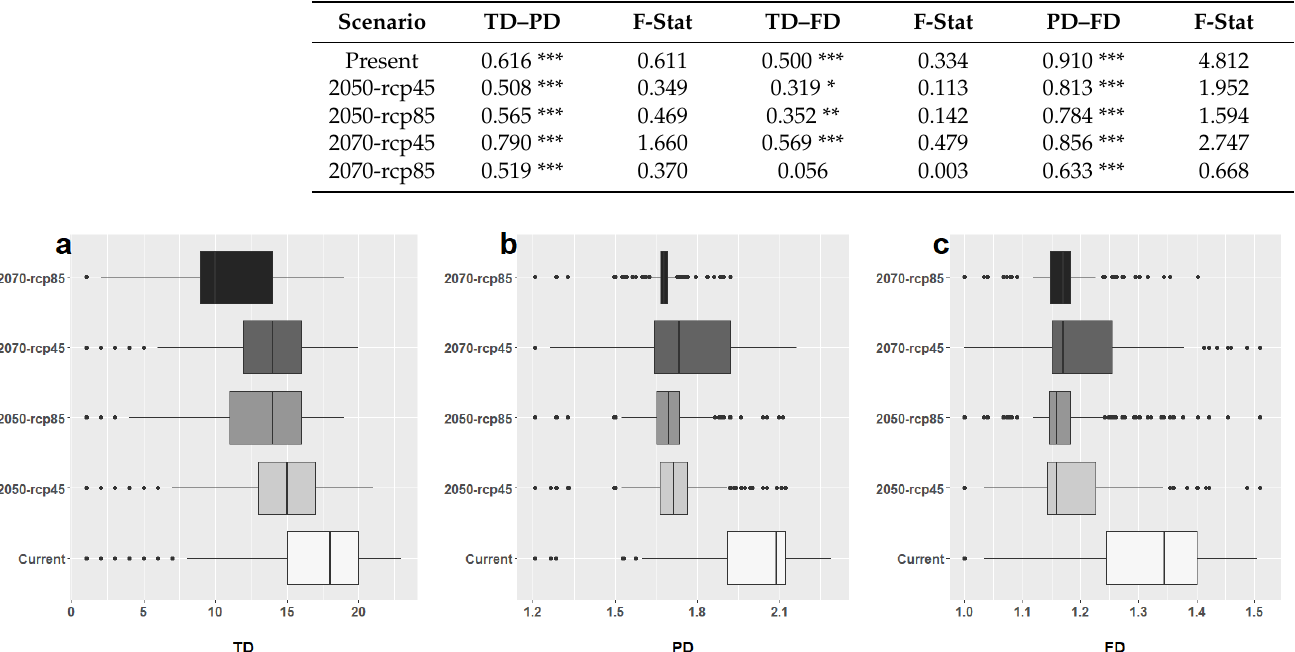
Figure 3. Mean diversity values comparison per dimension and scenario. ( a ) Taxonomic diversity, ( b ) phylogenetic diversity, and ( c ) functional diversity.